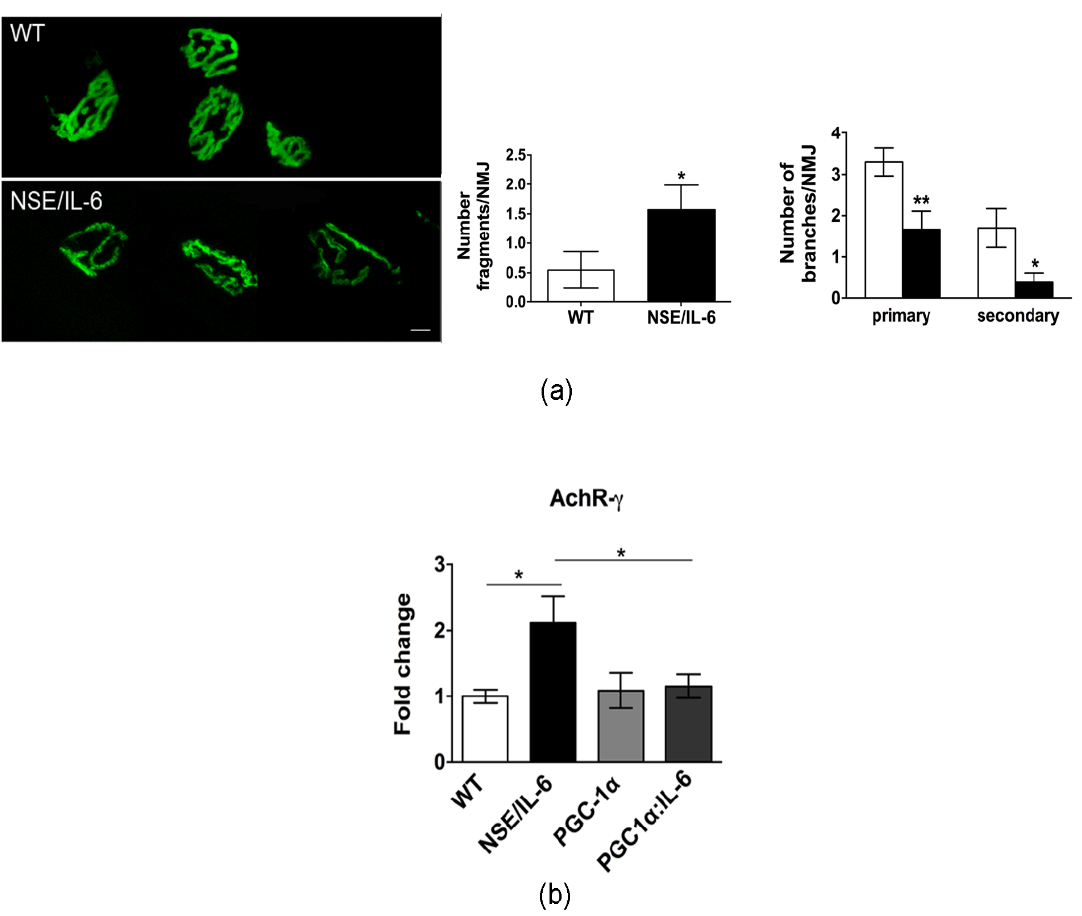
Figure 5. IL-6 overexpression affects neuromuscular junction (NMJ) destabilization. ( a ) Confocal microscopy of post-synaptic NMJ stained with a-bungarotoxin; representative images of one spatial series (from 0 to 50 µ m) composed of 25 optical sections with a step size of 2 µ m, from tibialis anterior of 6-month-old wild type and NSE/IL-6 mice. Scale bar 10 µ m. Graphs showing the degree of NMJ fragmentation (Number fragments/NMJ) and the topology of branching pattern (Number of branches/NMJ). Data are represented as average ± SEM n = 3; * p < 0.05, ** p < 0.01. Statistical significance assessed by Mann–Whitney Rank Sum Test. ( b ) Real time PCR for the expression of AchR- γ in soleus wild type (WT) and NSE/IL-6, PGC-1 α , and PGC1 α :IL-6 mice at 6 months of age. Values are expressed as fold change variations relative to WT and are presented as means ± SEM and are n = 3; * p < 0.05. Statistical significance assessed by Mann–Whitney Rank Sum Test.